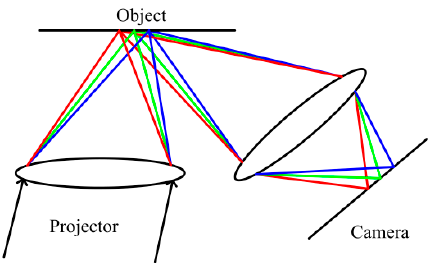
Figure 1. Lateral chromatic aberration (LCA) in structured light system.